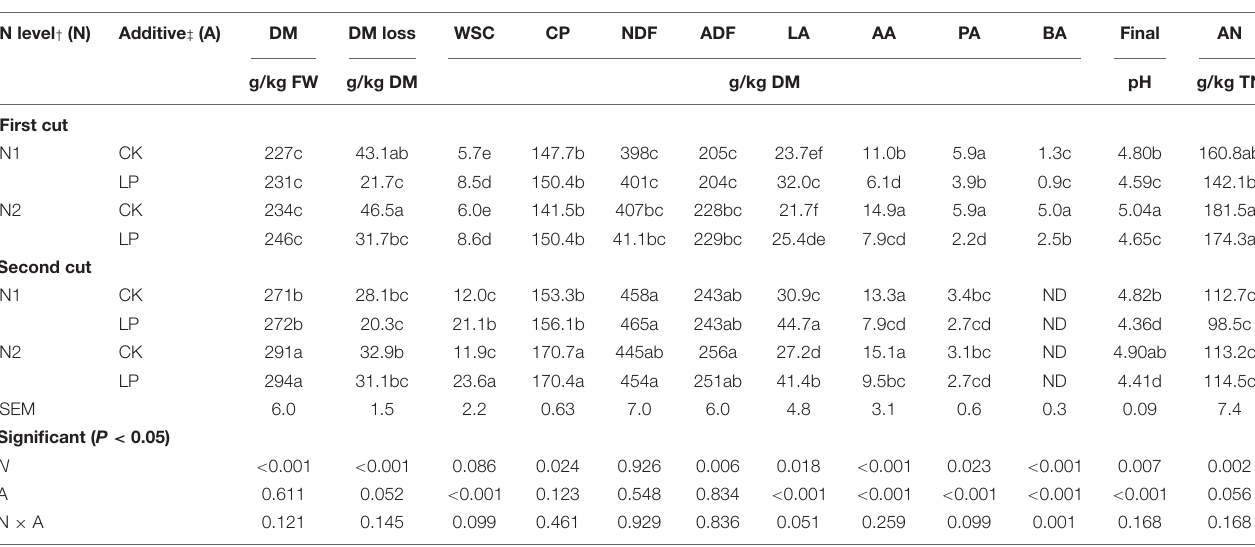
TABLE 2 | Chemical composition of paper mulberry